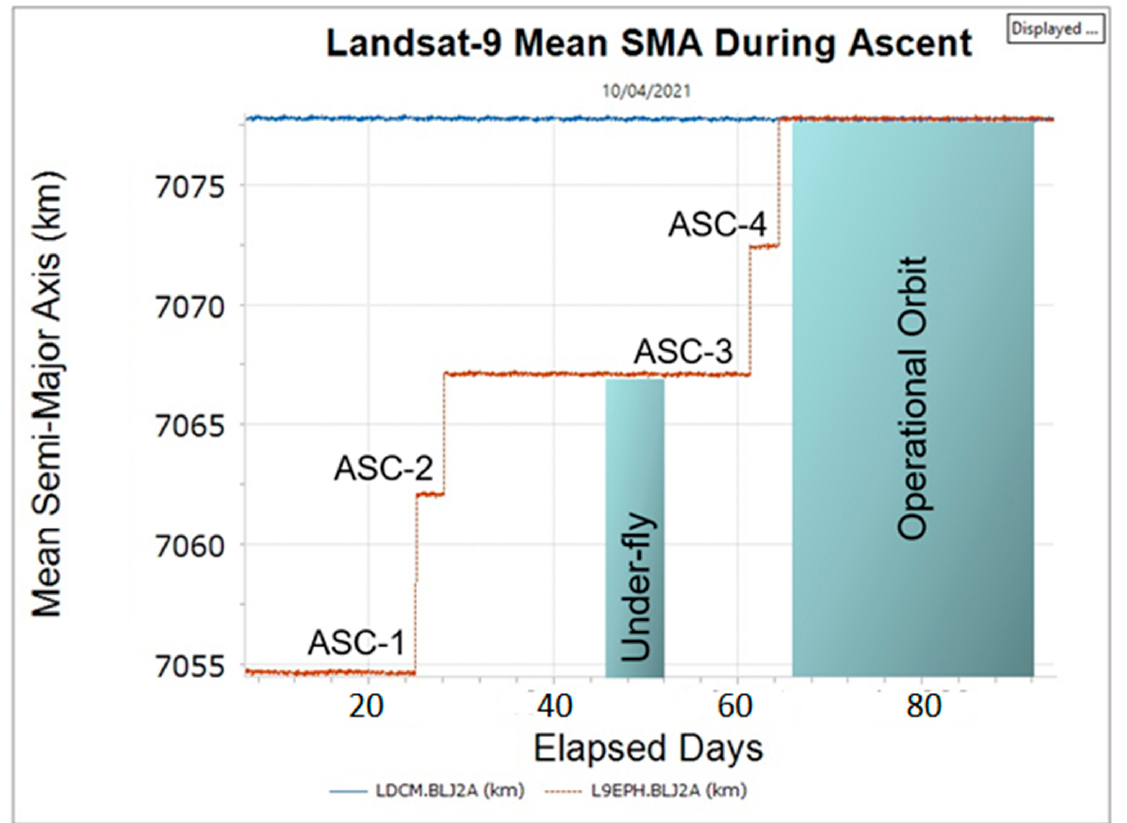
Figure 3. Landsat 9 Semi-major Axis versus Elapsed Days for launch .